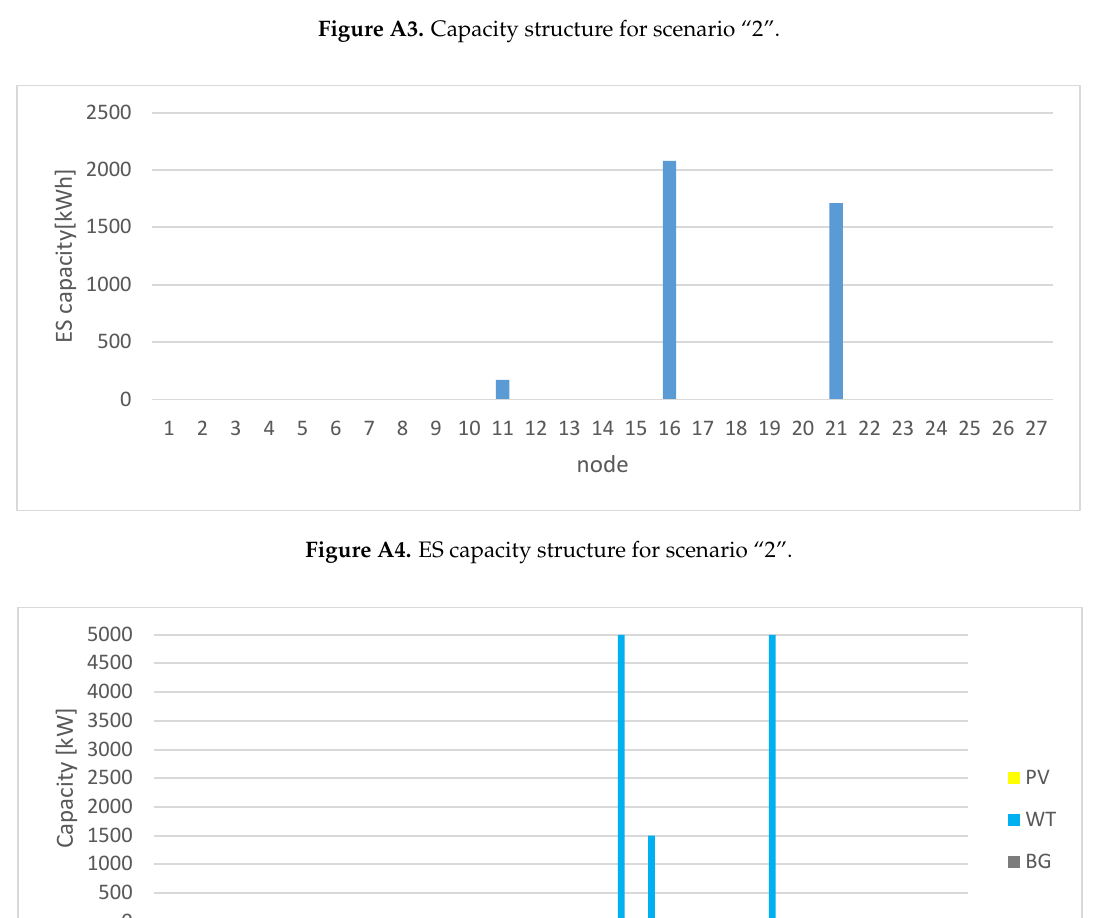
Figure A6. Capacity structure for scenario “4”. Figure A7. Capacity structure for scenario “5”.